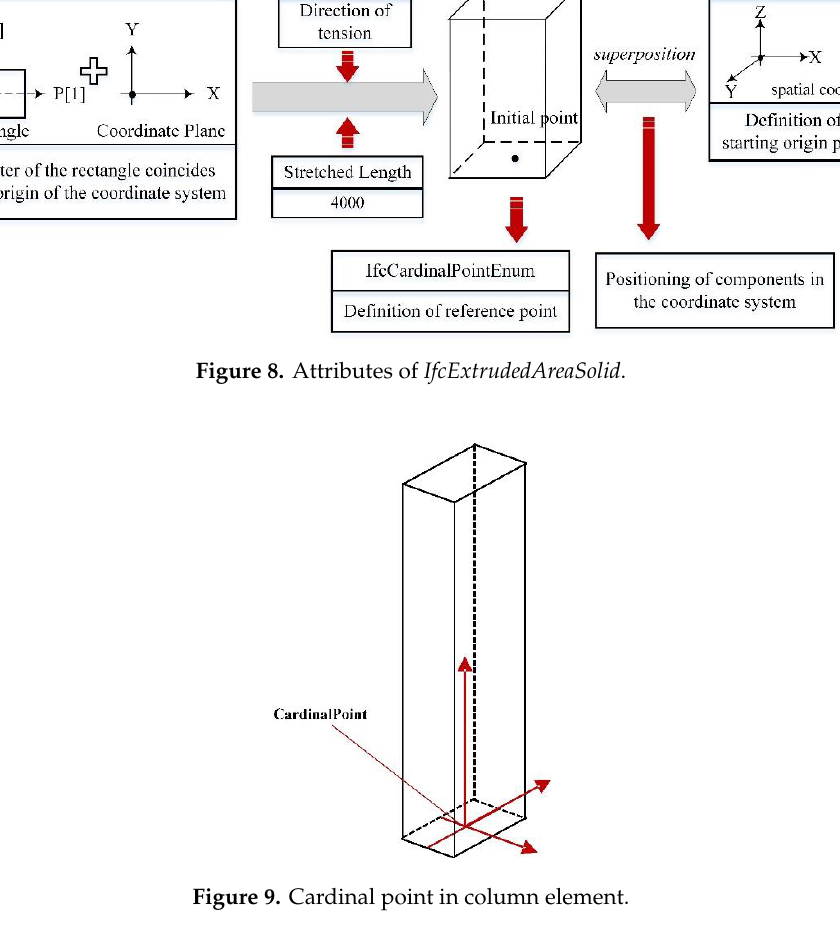
Figure 9. Cardinal point in column element. (2) Beams: the position information of the beam is given by the entity IfcLocalPlacement through coordinate values measured from the relative coordinate system in the nested layer structure. In the IFC schema, the beam element is also defined by “AXIS” and “BODY,” which express the 3D shape. The process of beam geometry representation is displayed in Figure 10. “AXIS” represents the axis parameter of a standard column, and “BODY” creates the 3D shape by SweptSolid or Clipping CSG (Constructive Solid Geometry). The axis is represented by the start and end-points in IfcPolyLine , which are given by entities #9 and #146. Entities #129, #132, and #19 constitute the source of the “BODY” definition for the beam geometry representation.